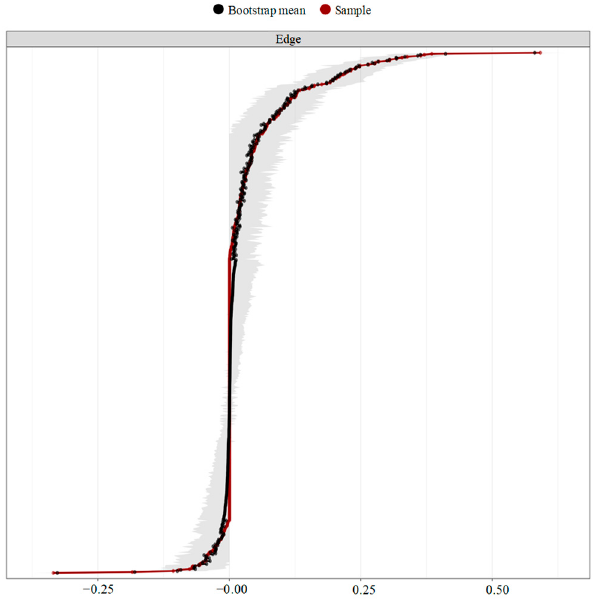
Figure 6. Bootstrap tests of the edge weight accuracy. Note: The grey areas represent the 95% confidence intervals.